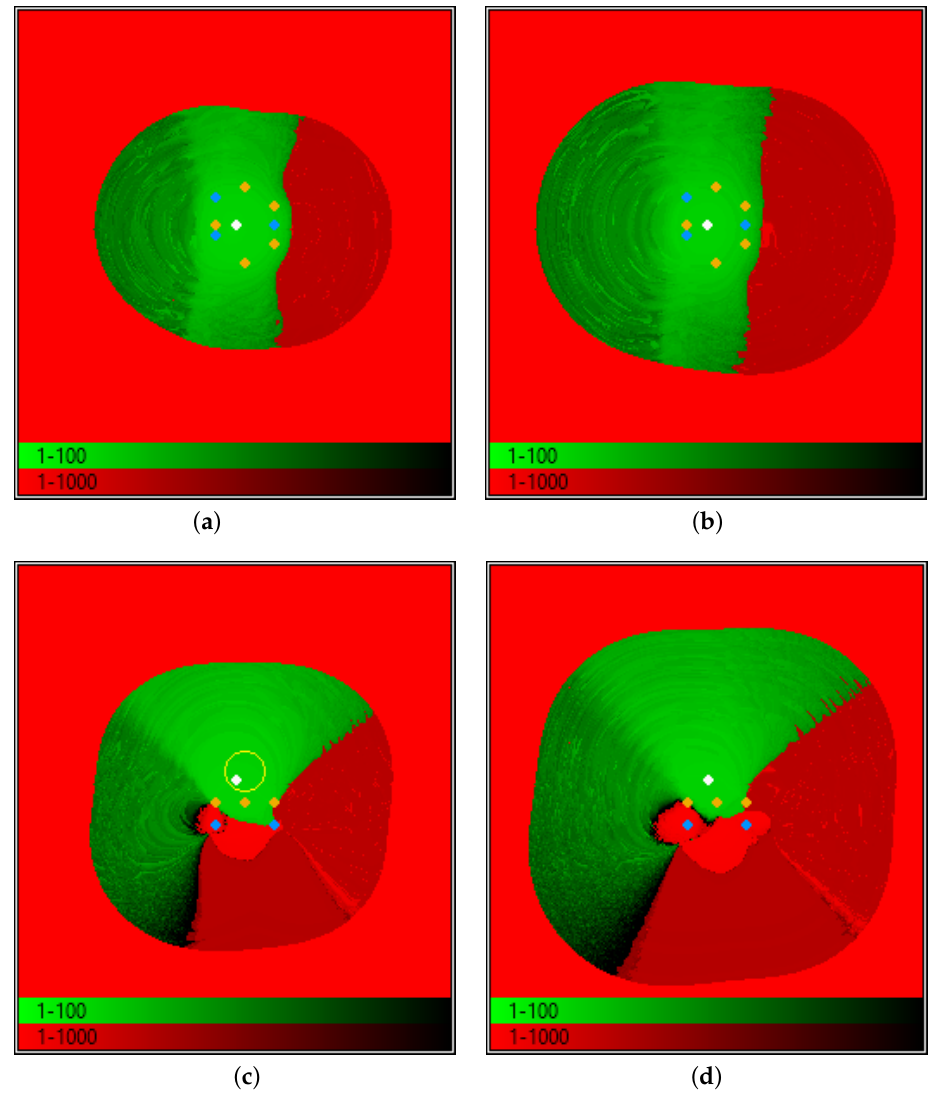
Figure 7. 2D convergence maps of xy ( a , b ) and xz ( c , d ) sections. The remaining 7 parameters are set to their exact values ( a , c ) or to their default values ( b , d ). The target (white dot) is in a nearly axial position, at z = 31 mm. Unexpectedly, using wrong guesses for (cid:126) B g and (cid:126) m and wrong (larger) z makes the ( x , y ) convergence area larger than using exact values. All these maps describe a 300 mm × 300 mm area, the yellow circle in ( c ) corresponds to a sphere (26 mm in diameter) that is the typical size of human eye